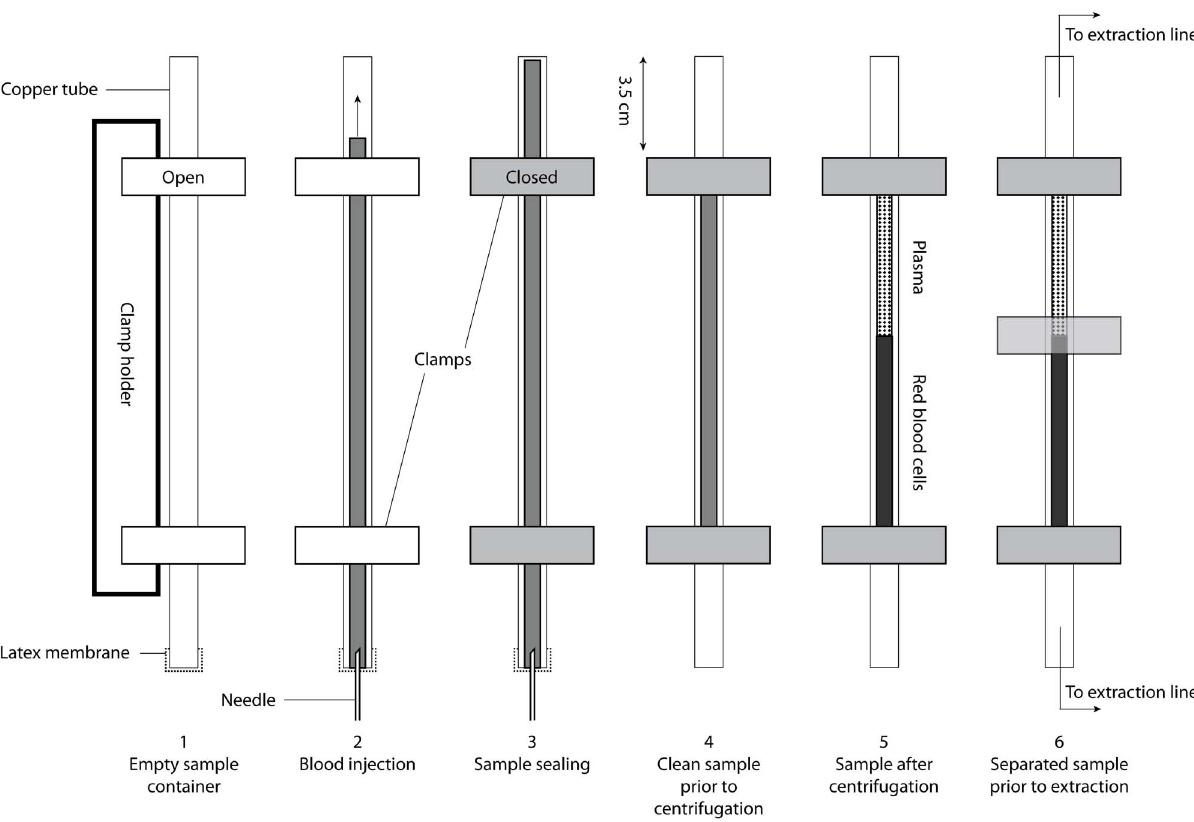
Figure 1. Acquisition and preparation of a blood sample for noble-gas analysis. Whole blood in injected from a syringe through a hypodermic needle into a copper tube held vertically (Steps 1–2). After closing the sample with two special metal clamps (Step 3), the copper tube is cleaned (Step 4) and centrifuged at 2300 rpm in a centrifuge with a swing-out rotor (Step 5). After centrifugation, the plasma and red blood cells are separated using a third clamp (Step 6).